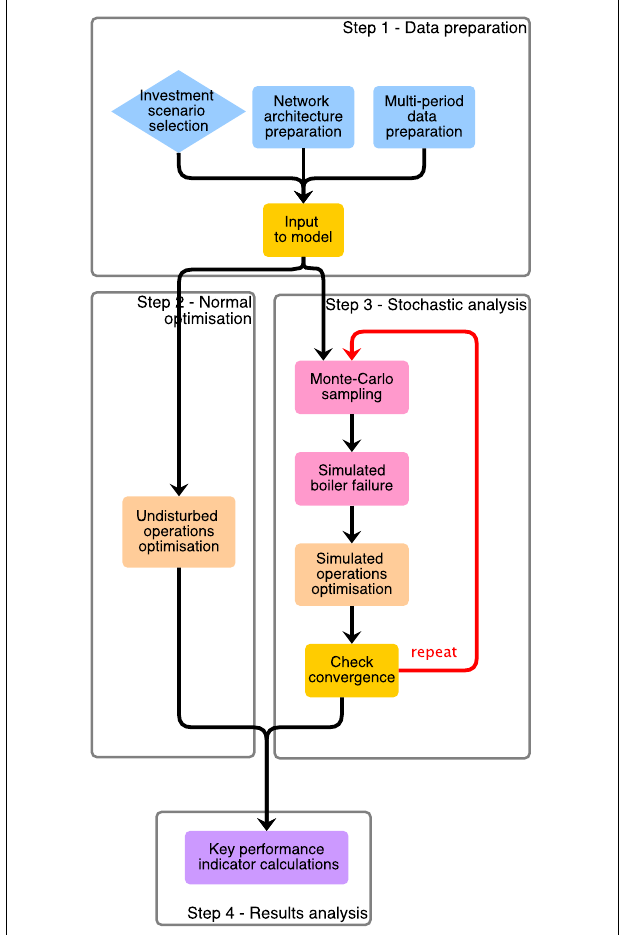
FIGURE 2 | Simulated boiler failure algorithm